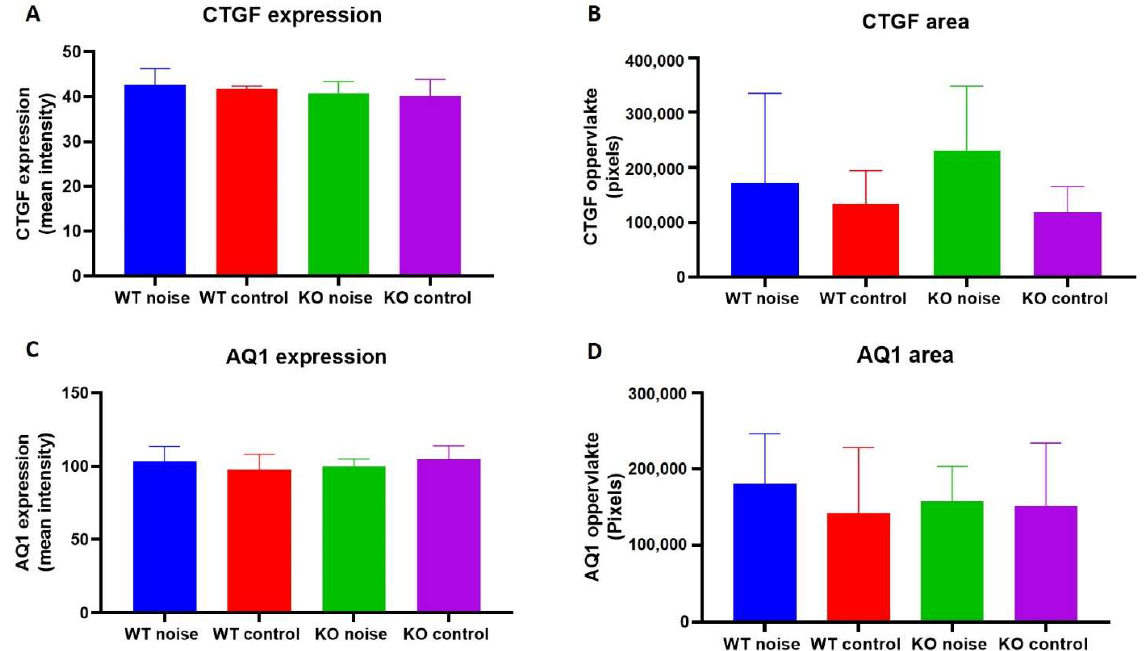
Figure 8. CTGF expression ( A ) and area of expression ( B ) in the spiral ligament across all groups. AQ1 expression ( C ) and area of expression ( D ) in the spiral ligament between Coch +/+ mice exposed to noise ( n = 13), Coch +/+ control mice ( n = 9), Coch − / − mice exposed to noise ( n = 13) and Coch − / − control mice ( n = 13). No significant differences were found in expression level and expression area of type III and type IV fibrocytes.